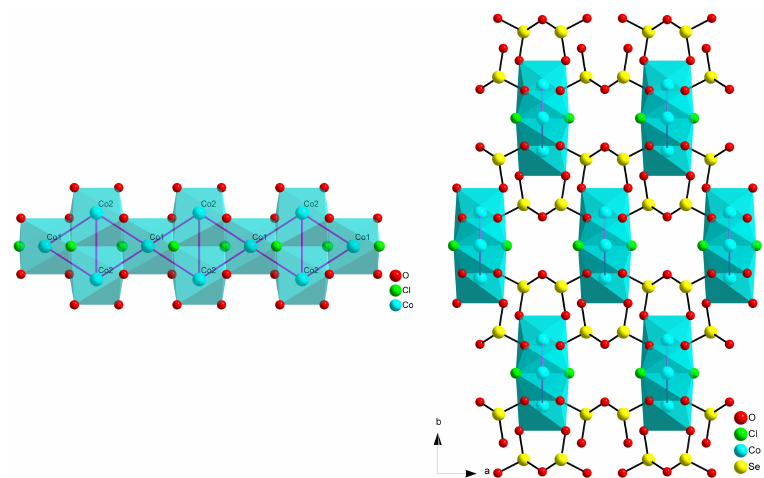
Figure 24. The chain built by [CoO 4 Cl 2 ] octahedra in the crystal structure of Co 3 (Se 2 O 5 )Cl 2 (left) and view on chains interconnected by diselenite groups (right) [75].